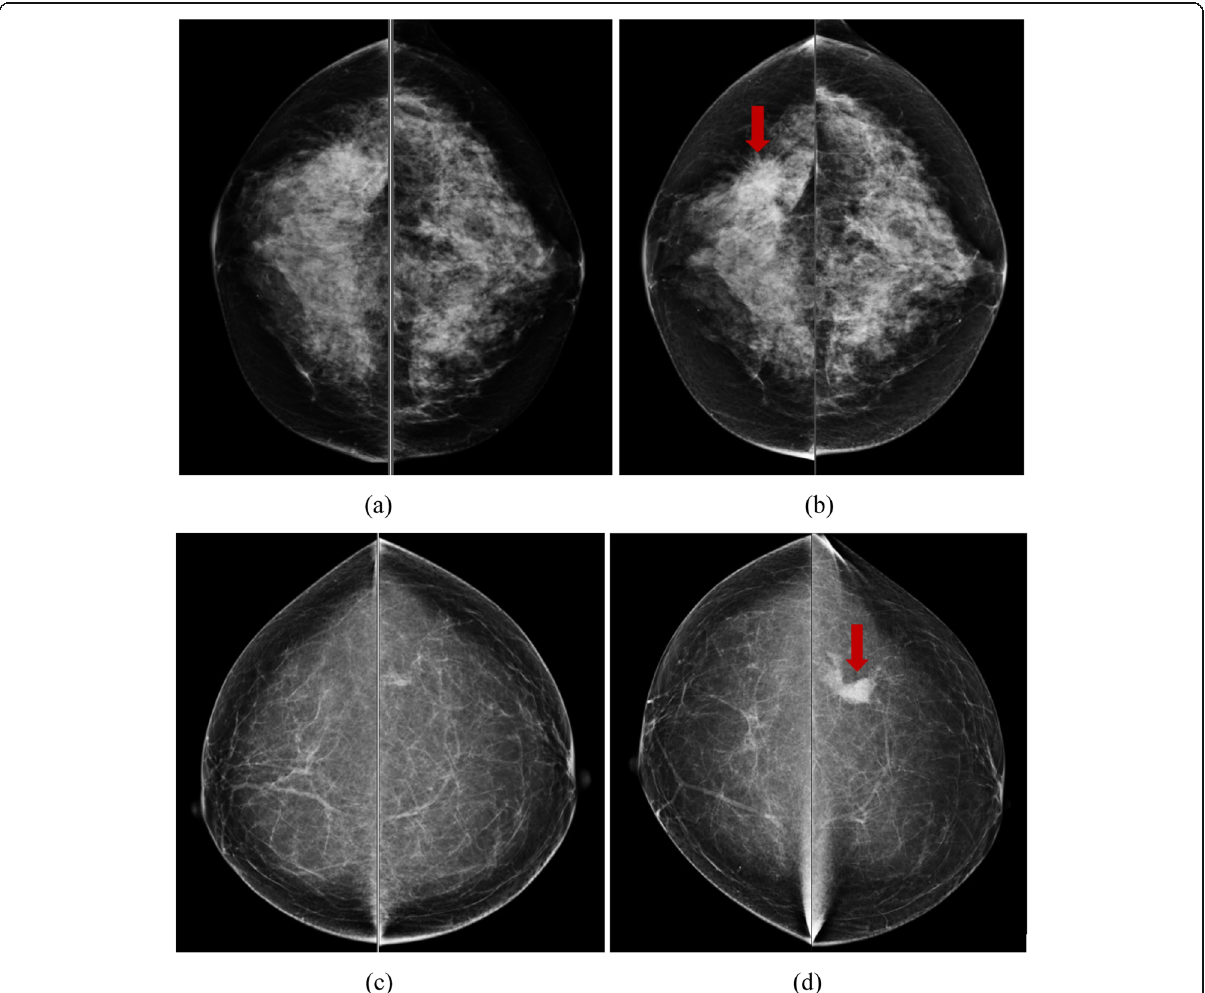
Fig. 7 Prediction results of applying our short-term breast cancer risk models to “ prior ” negative images of two cases ( a and c ). “ Current ” images of two cases in which malignant tumors were detected (red arrows) ( b and d ). Our model correctly predicted case ( a ) as a high-risk case but the misclassified case ( c ) as a low-risk